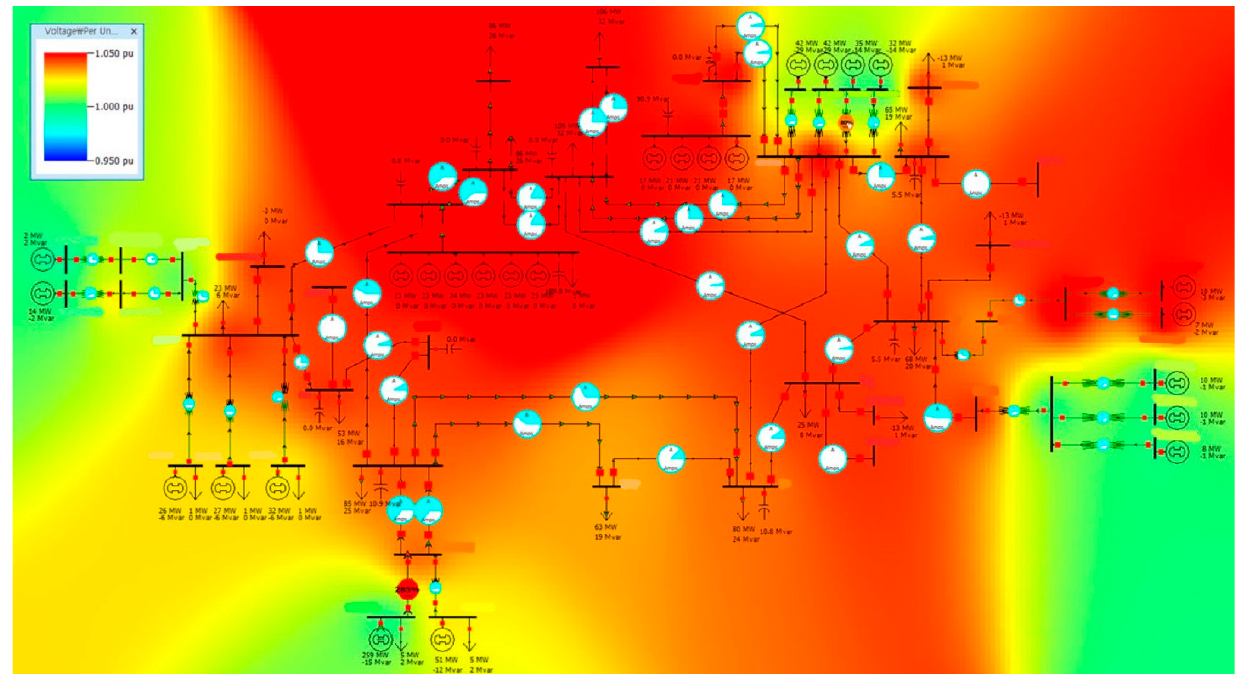
Figure 10. Voltage profile review; reliability criteria: 0.95–1.05 p.u.